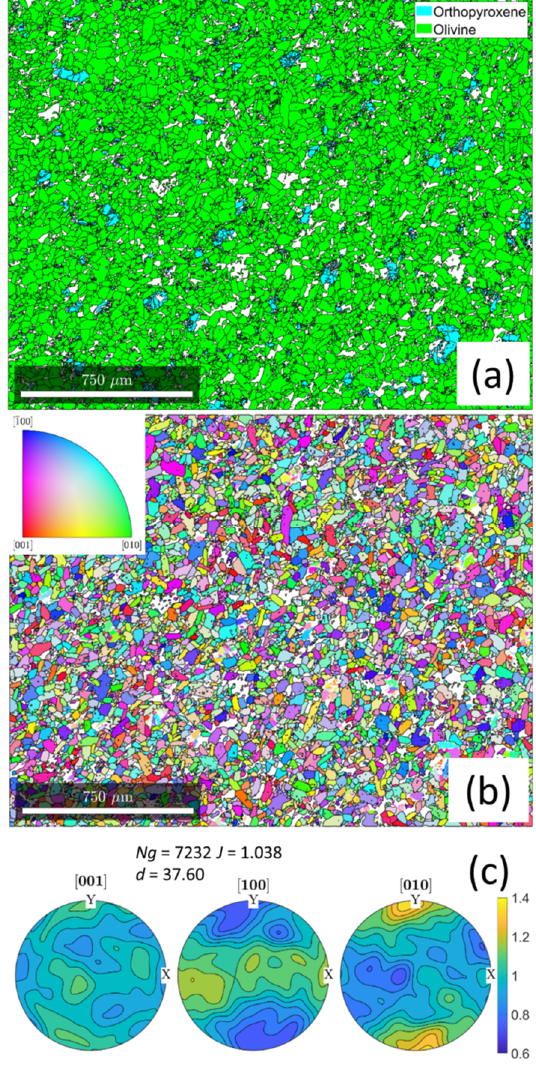
Figure 1. Electron Back-Scatter Diffraction (EBSD) data of the HIP sample used as starting material for deformation experiments. ( a ) Phase mapping reveals an equilibrium texture with low porosity (white pixels are unindexed pixels due to poor diffraction quality). Grain boundaries are drawn with black lines. The sample is constituted of about 6 vol% of MgGeO 3 pyroxene. ( b ) Crystal orientations color-coded according to the inverse pole figure given in the inset. Ge-olivine grains have an average grain size of 37.6 µ m. They are tabular and show no visible internal deformation as evidenced